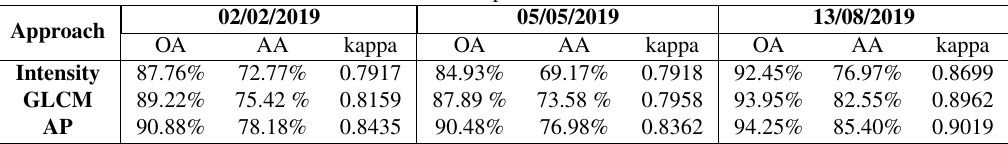
Table 3: Comparative